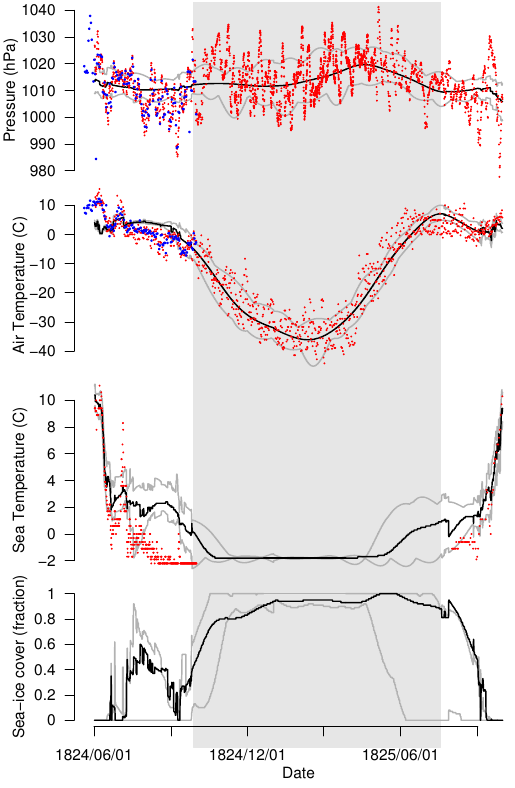
Fig. 8. Weather observations from HMS Hecla and Fury in 1824– 1825, compared with modern values. The red and blue points are the expedition’s observations (red from Parry, 1826, and blue from Austin, 1824), the black and grey lines are the mean, max and min values from modern datasets (monthly averages interpolated to daily, 1979-2004; SST and sea-ice from Rayner et al., 2003, AT from Rigor et al., 2000, and pressure from Allan and Ansell, 2006). The grey band marks the period the expedition spent in winter har-